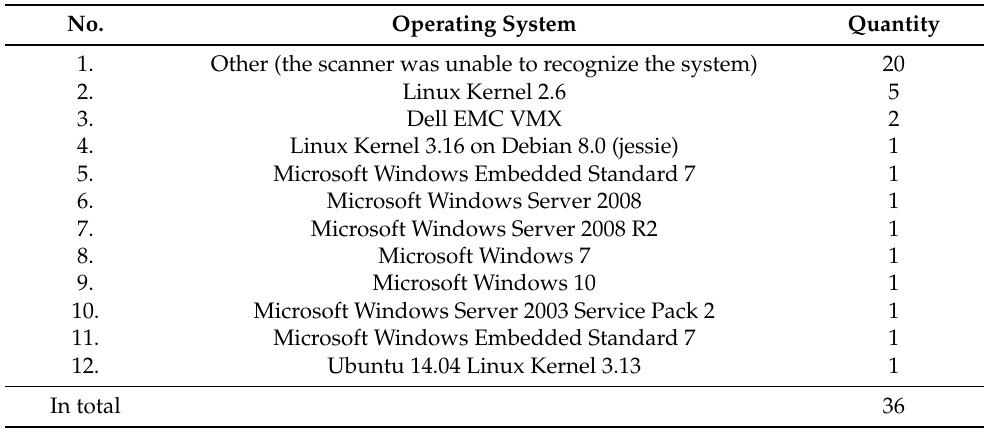
Table 4. Numbers and types of operating systems detected for environment B.